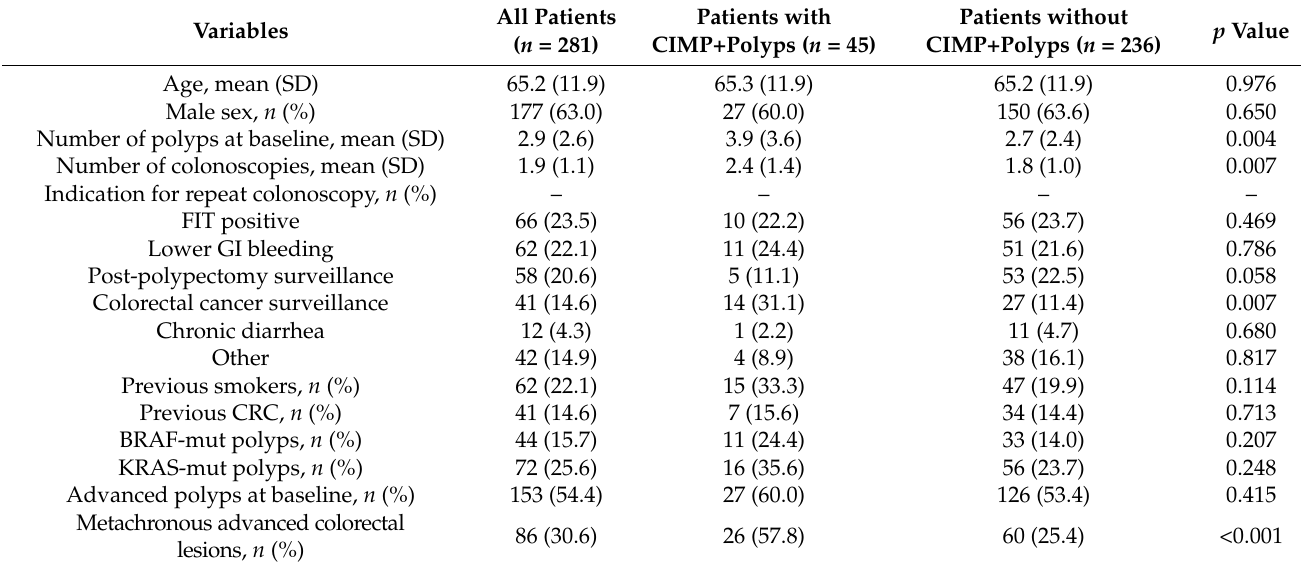
Table 2. Patients’ characteristics according to CIMP status of polyps at baseline